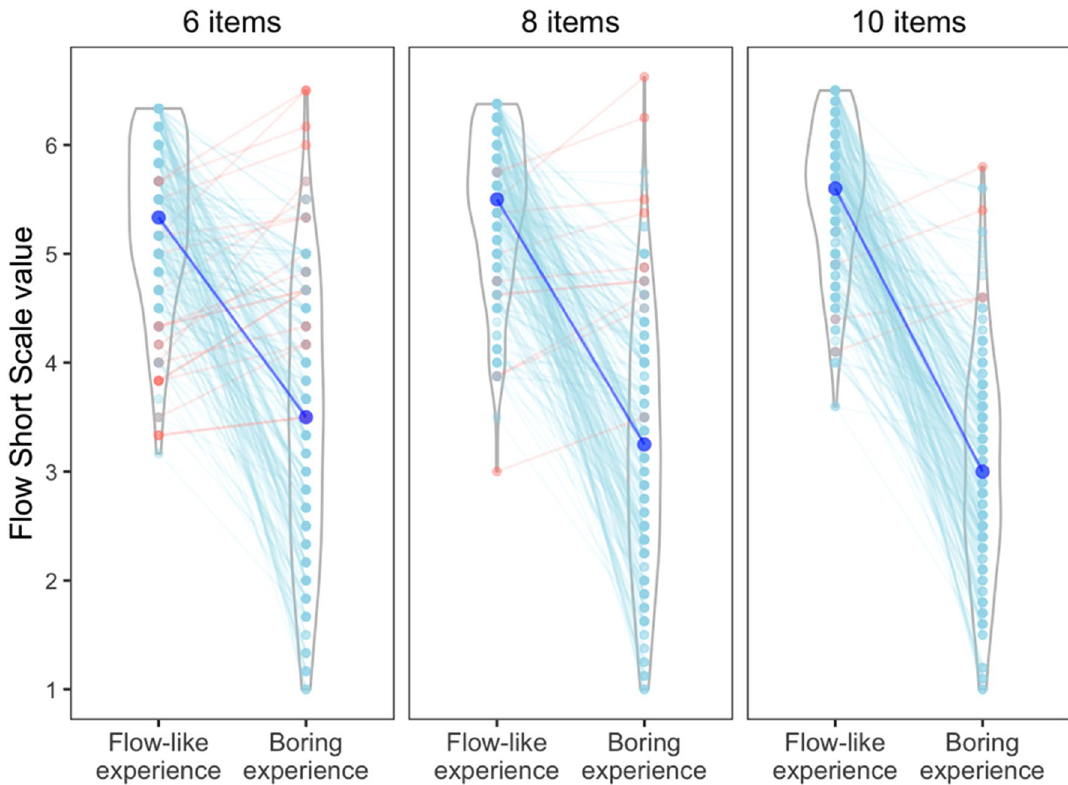
Figure 5. Comparison of Flow Short Scale (FSS) values between self-identified Flow-like and boring experiences, separately for 6-item-, 8-item-, and 10-item versions of FSS. Large blue dots represent median values, and the smaller dots represent observations from individuals. Red slopes indicate individuals who reported experiencing more Flow during their self-identified ‘boring’ experience, perhaps due to misunderstanding task